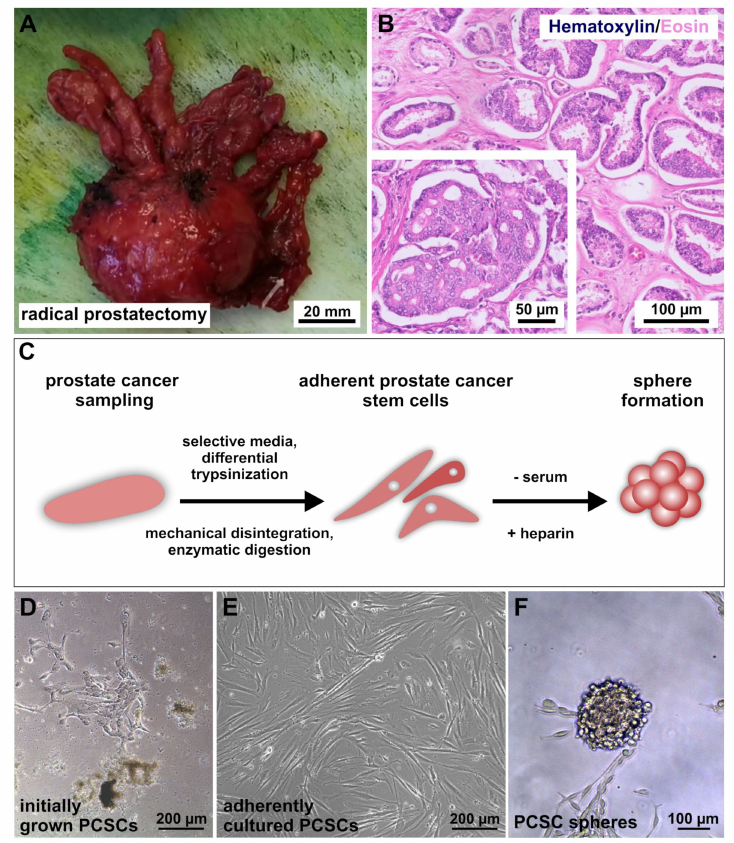
Figure 1. Isolation and cultivation of primary putative prostate cancer stem cells. ( A ) Photograph of a cancerogenic prostate (for sample PIX) after a radical robotic-assisted prostatectomy. ( B ) Exemplary hematoxylin/eosin stainings from PXI acinar adenocarcinoma with a Gleason score of 3 + 4. The dominant pattern 3 (outer segment) depicts variably sized individual glands, while the inner segment further shows minor pattern 4 with cribriform glands. ( C ) Schematic procedure after surgical removal of tumor-infiltrated prostates. Tissue samples were minced, digested and further cultured under cancer stem cell-selecting conditions after enrichment via differential trypsinization processes. ( D – F ) Successfully cultured putative prostate cancer stem cells (PCSCs, example from donor PXI) after isolation from primary tumor tissues. Cells grew adherently by cultivation with fetal calf serum ( D , E ) and were able to form spheres via the replacement of serum with heparin ( F